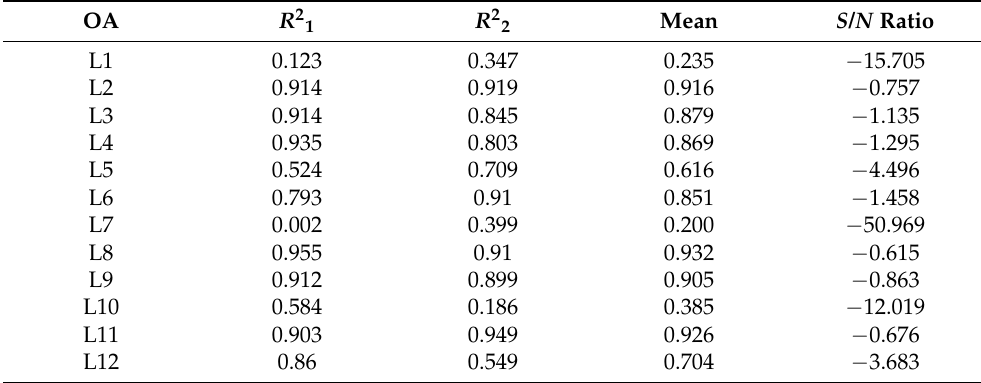
Table 4. R 2 , mean, and signal-to-noise ( S/N ) ratio in each run of OA L